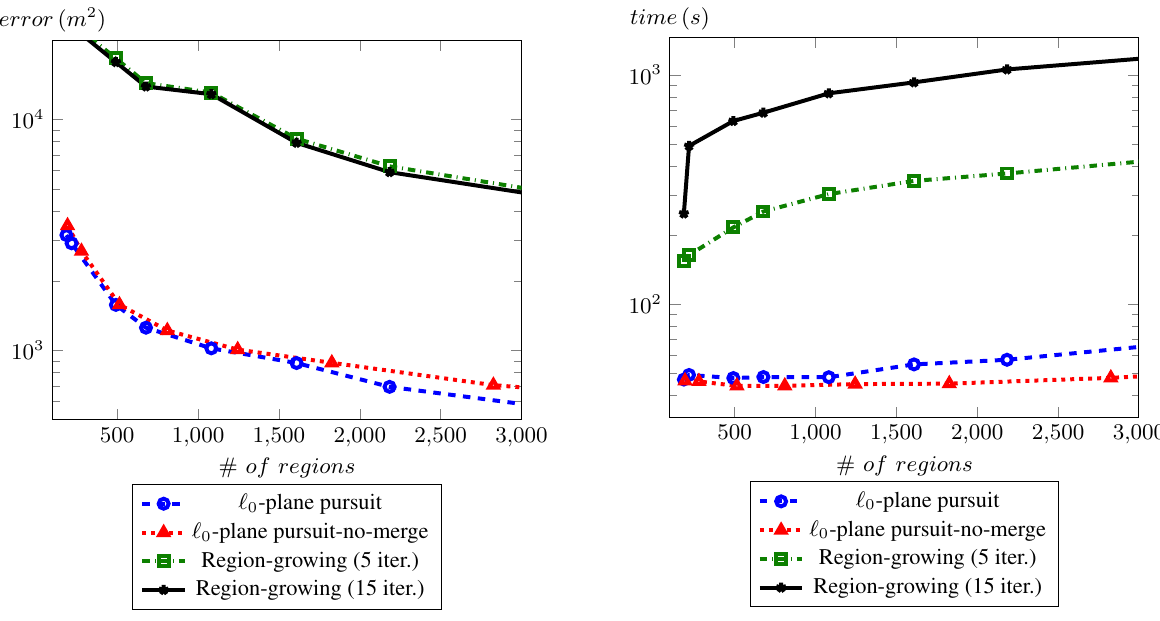
Figure 4. Comparison of the computation time in seconds between our method and the region-growing